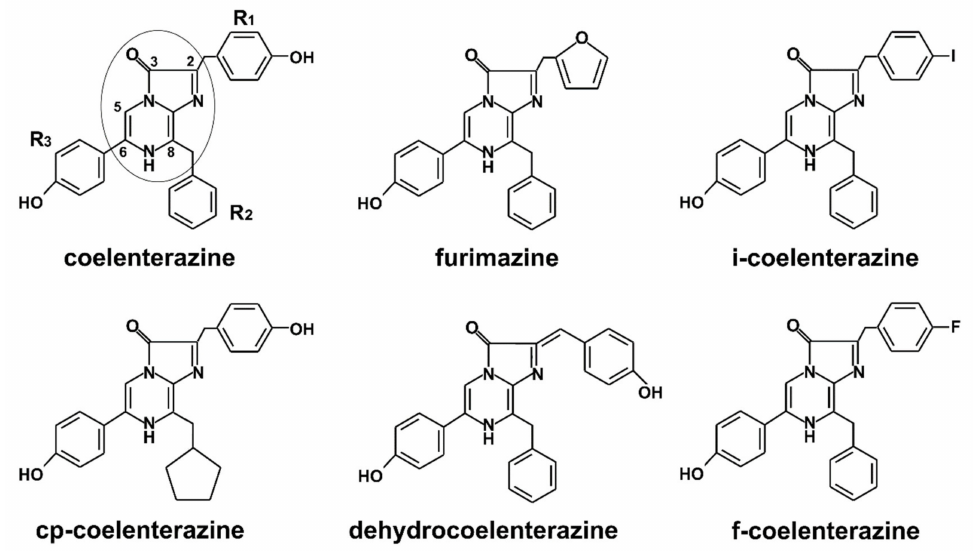
Figure 2. Chemical structures of coelenterazine and its analogues, mentioned in the review. Imidazopyrazinone core is shown in a